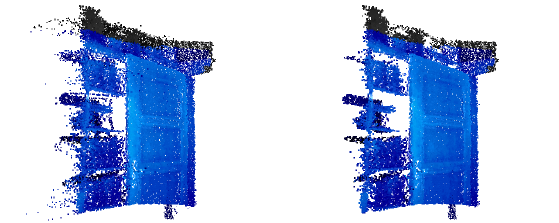
Figure 14: Side view onto the infrared-textured point cloud be- fore and after removing unreliable